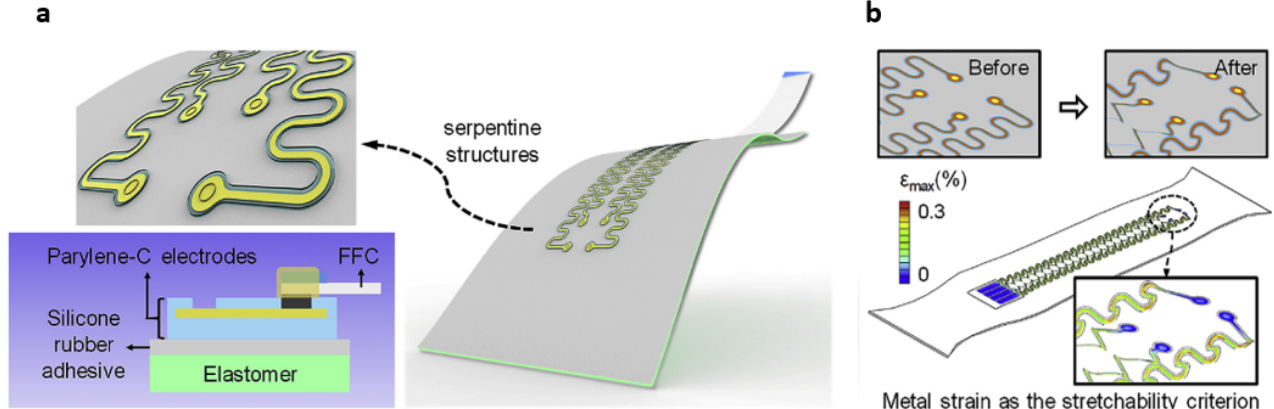
Figure 2. Stretchable Parylene-C electrodes. ( a ) A schematic of stretchable parylene-C electrodes with serpentine interconnects to increase the stretchability of the electrodes. A silicone rubber adhesive was used to stick the electrodes onto the elastomer substrate. Attaching the electrodes to an elastic substrate limited external deformation [43]. ( b ) A diagram of the strain applied to the electrodes when stretched [43]. Reprinted with permission from Ref. [43]. Copyright 2020 The Chinese Ceramic